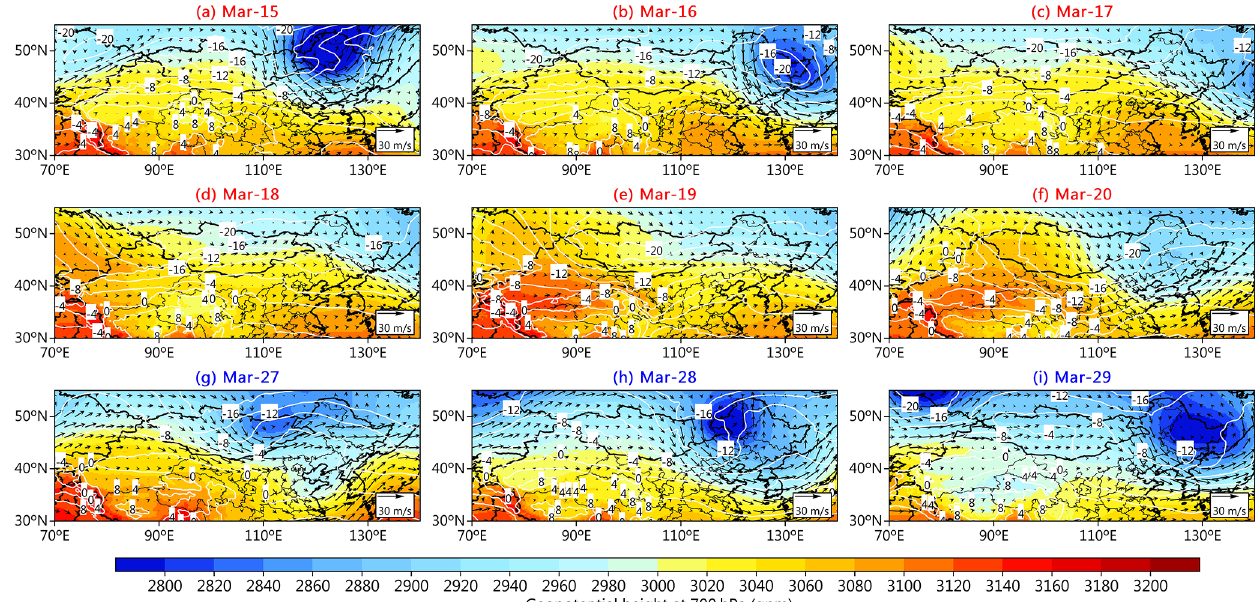
Figure 12. Pattern evolutions of ERA5 geopotential height (shading; gpm), temperature (contours; ◦ C), and wind vectors (black arrows; ms − 1 ) at 700hPa on (a) 15, (b) 16, (c) 17, (d) 18, (e) 19, (f) 20, (g) 27, (h) 28, and (i) 29 March